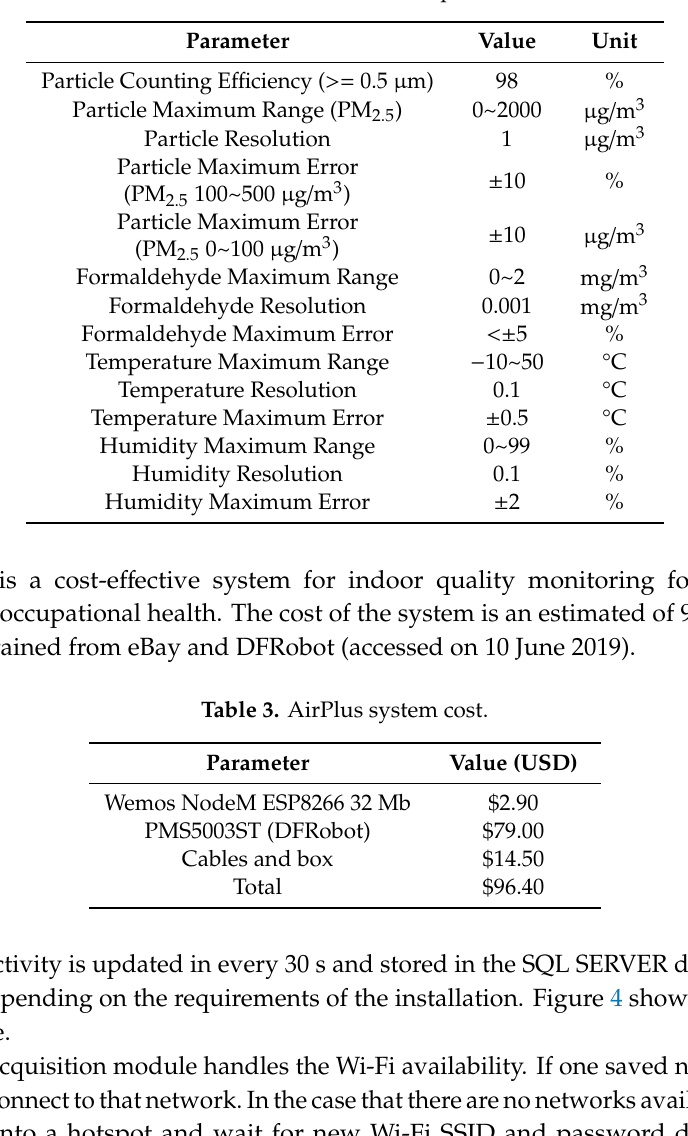
Table 2. PMS5003ST technical specification.